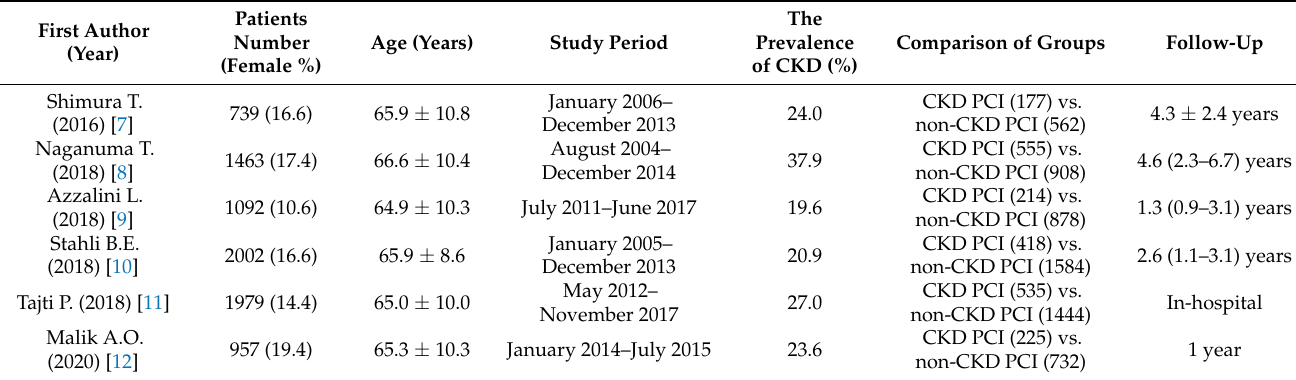
Table 2. Characteristics of the 6 included